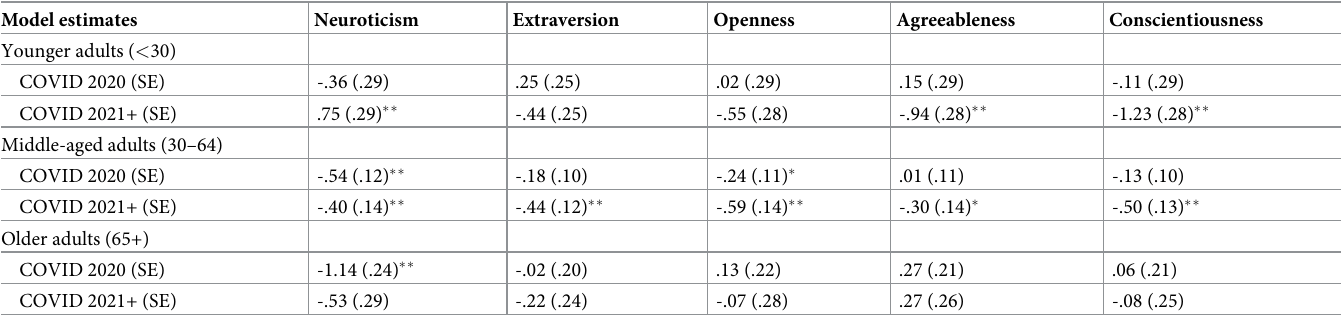
Table 3. Effect of the pandemic on personality change by age